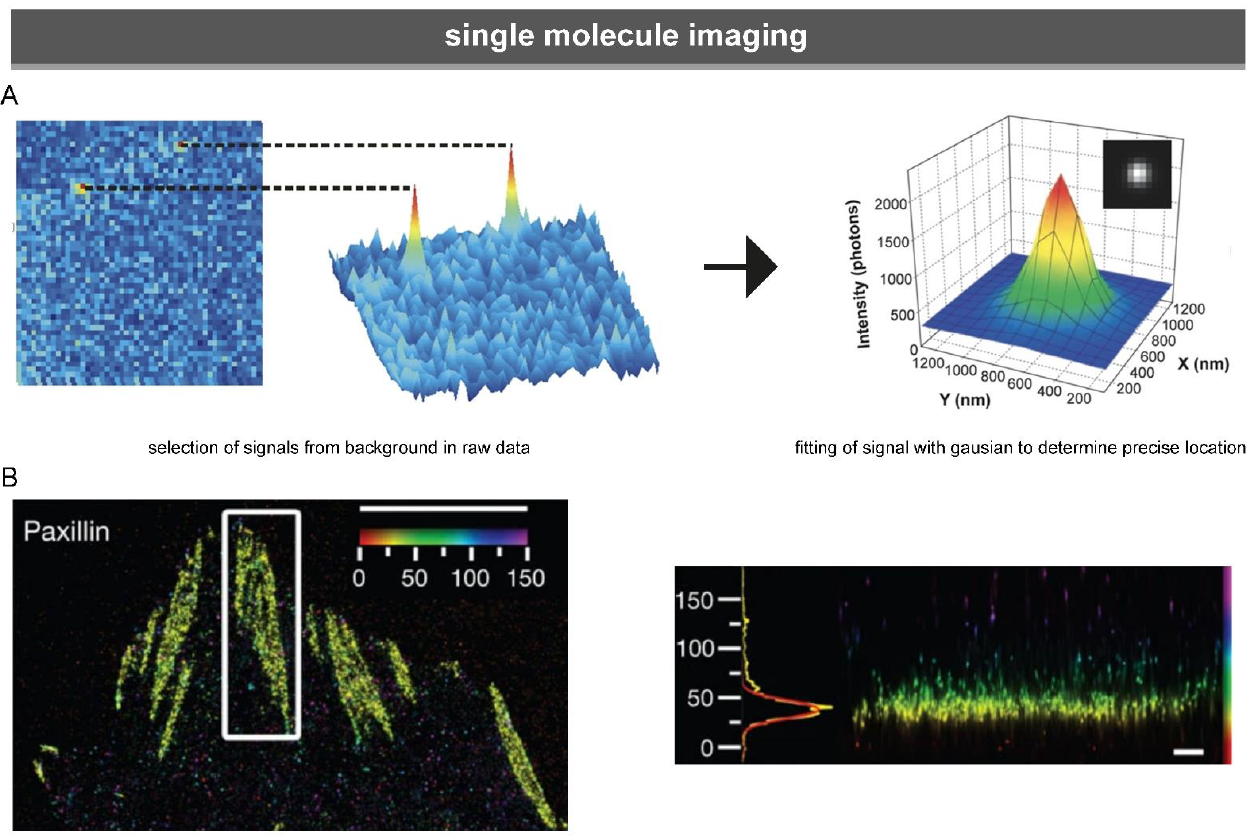
Figure 6. Single-molecule super-resolution microscopy. ( A ) Schematic illustration of single-molecule super-resolution microscopy. Adapted from van Royen et al. 2014 [156] ( B ) Single-molecule super-resolution image of paxillin-tdEos expressed in U2OS cells in top-view ( left ) and side view ( right ) of boxed area. Colour indicates vertical (z) position relative to the substrate (0) in nm. Side view includes corresponding z histogram and fit. Scale bar: 5 µm. Adapted from Kanchanawong et al. 2010 [37].